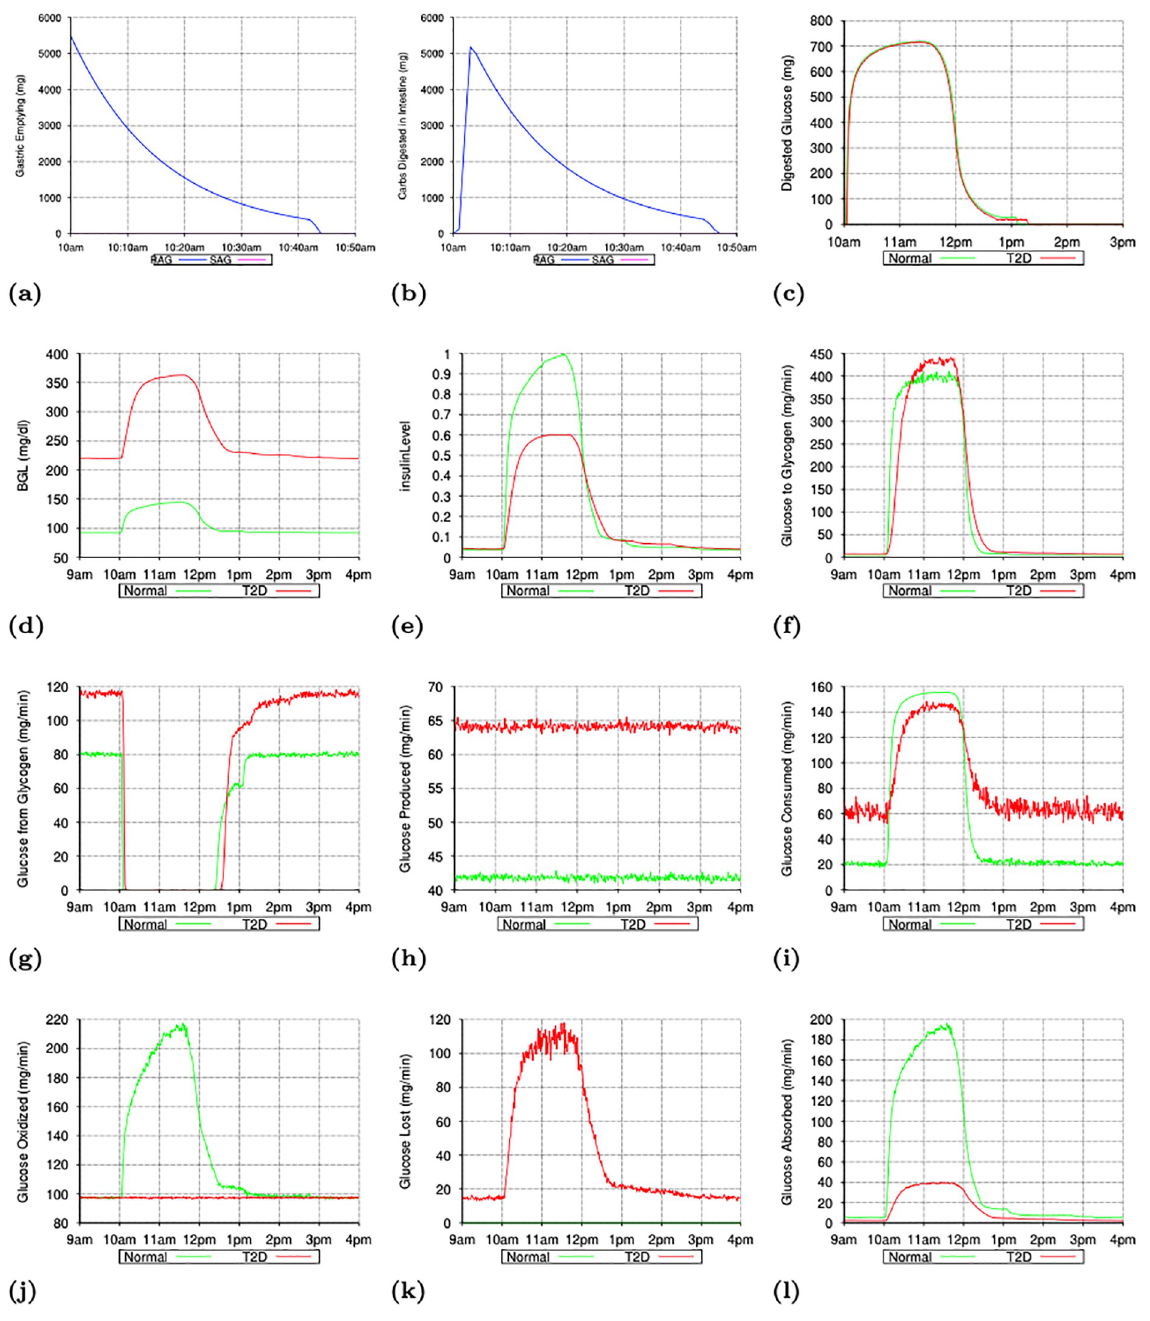
Fig 1. Simulating a meal event for a normal and a subject with Type 2 Diabetes (T2D): Minute-by-minute values of interest In simulations with a particular seed for random number generation. (a): Gastric Emptying (mg/minute). (b): Carbohydrate Digestion in Intestine (mg/minute). (c): Appearance of Digested Glucose in PortalVein (mg/min). (d): Blood Glucose Level (mg/dl). (e): Insulin Level. (f): Liver Glycogen Synthesis. (g): Liver Glycogen Breakdown. (h): Total Gluconeogenesis in Liver and Kidneys. (i): Total Glycolysis in All Organs. (j): Total Glucose Oxidation in All Organs. (k): Glucose Excretion in Urine. (l): Glucose Absorption in Muscles.